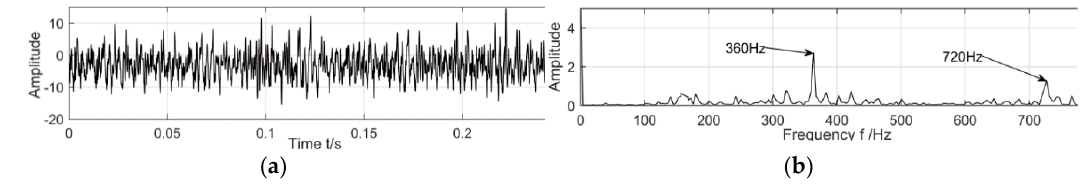
Figure 11. Time-frequency spectrum of complex fault signal of gear box. ( a ) Time domain of complex fault vibration signal; and ( b ) Spectrum of complex fault vibration signal.